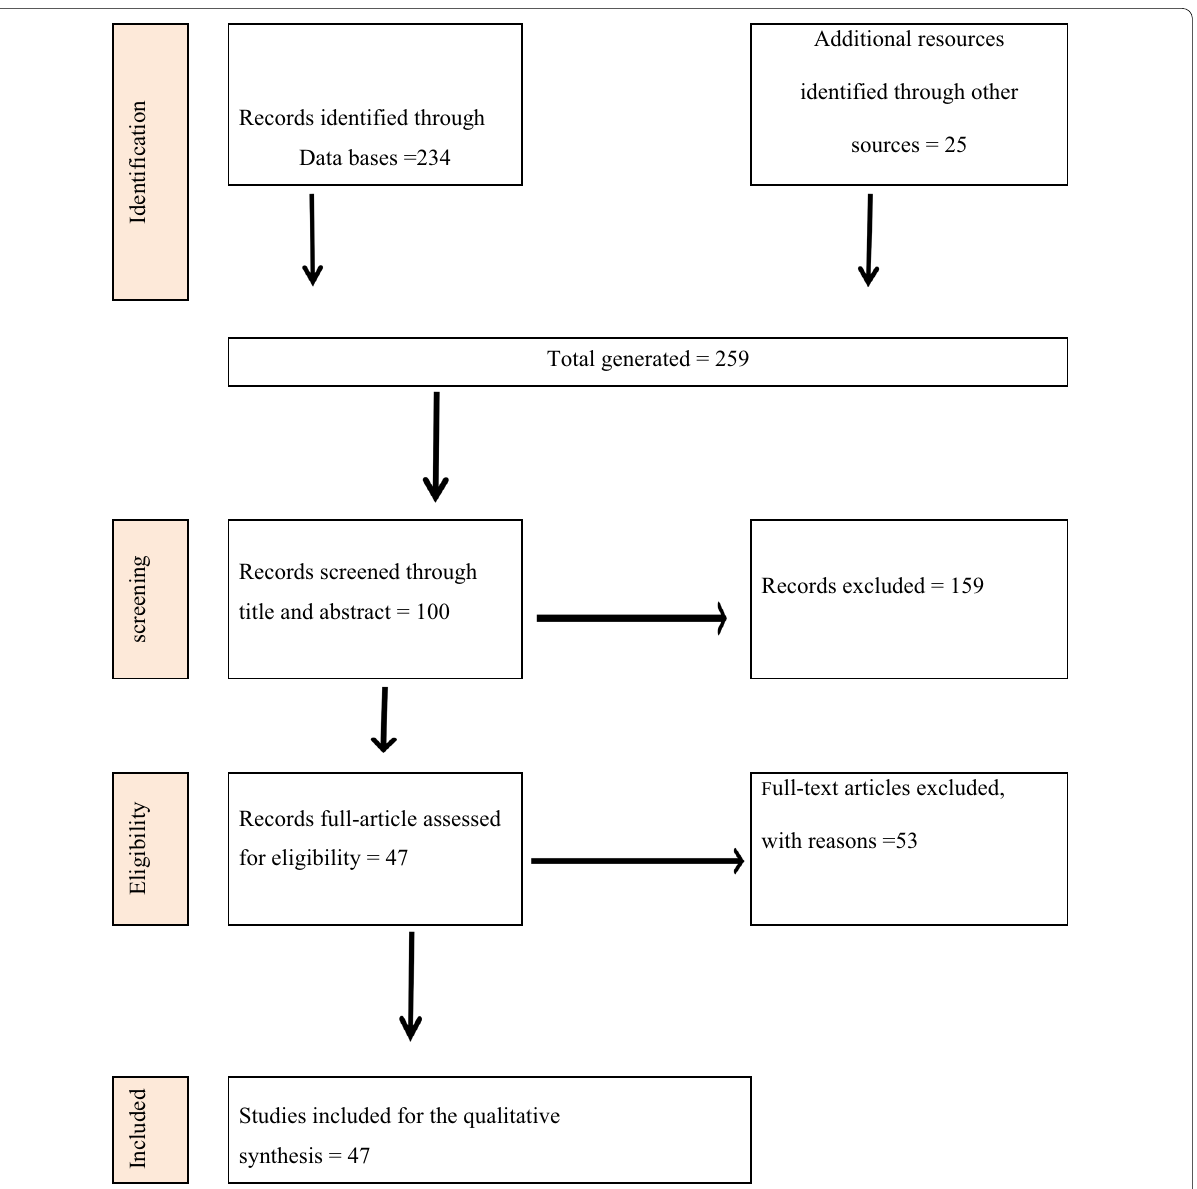
Fig.1 The flowchart for determining which studies are qualified focuses on the limitations and potential of crossbreeding as a basis for goat production by Ethiopian smallholder farmers